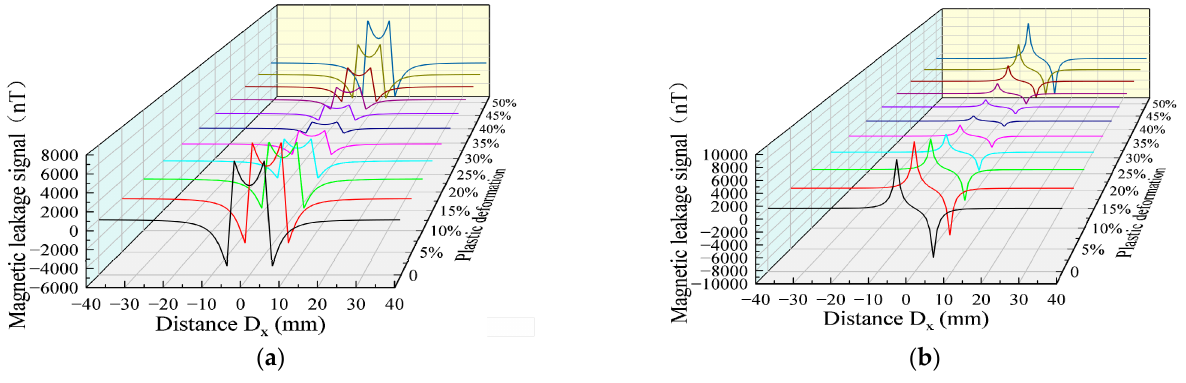
Figure 8. MFL signals with different plastic deformation values. ( a ) Axial component of MFL signals with different plastic deformation values. ( b ) Radial component of MFL signals with different plastic deformation values.